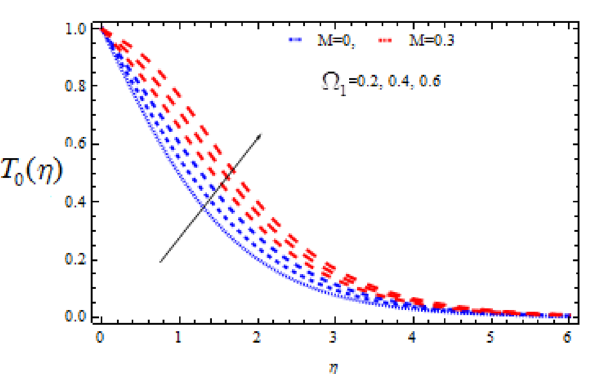
Figure 10. Consequence of (cid:31) 1 on T 0 (η)